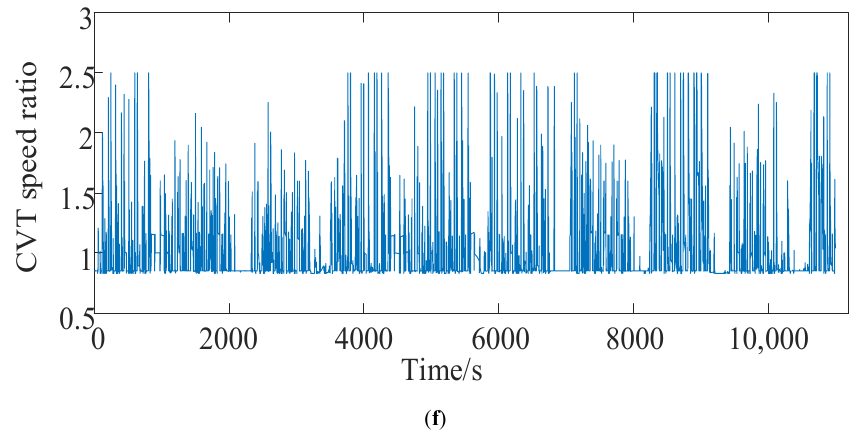
Figure 16. Simulation results of the energy management strategy based on dynamic programming (DP): ( a ) battery Soc; ( b ) accumulator Soc; ( c ) motor torque; ( d ) engine torque; ( e ) hydraulic pump/motor torque; ( f ) CVT speed ratio.